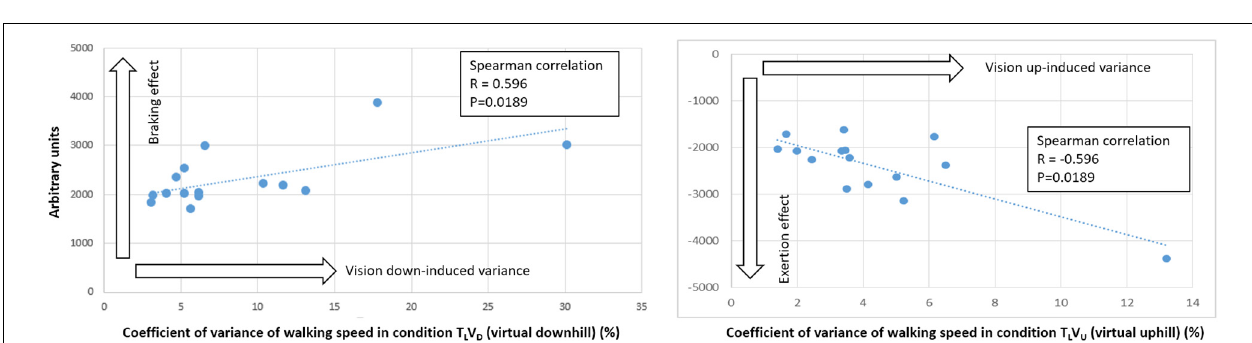
FIGURE 11 | Vision-induced walking speed variance correlates with gravity-induced effects. Walking speed variance evident in visually induced incongruent conditions was significantly correlated with gravity-induced braking and exertion effects on walking speed in congruent conditions. Coefficient of variance of walking speed was calculated during the first 20 s post-transition. The greater the walking speed variance caused by an incongruent visual transition to a downhill scene (condition T L V D ), the larger the braking effect. Likewise, the greater the walking speed variance caused by an incongruent visual transition to an uphill scene (condition T L V U ), the larger the exertion effect. Note that the Spearman correlation was identical in both uphill and downhill cases, suggesting that the relationship between walking speed variance and gravity-induced changes in walking was the same for participants in both the downhill and uphill cases. These results support the presence of individualized susceptibility profiles for external vision-induced forces impinging upon locomotion.